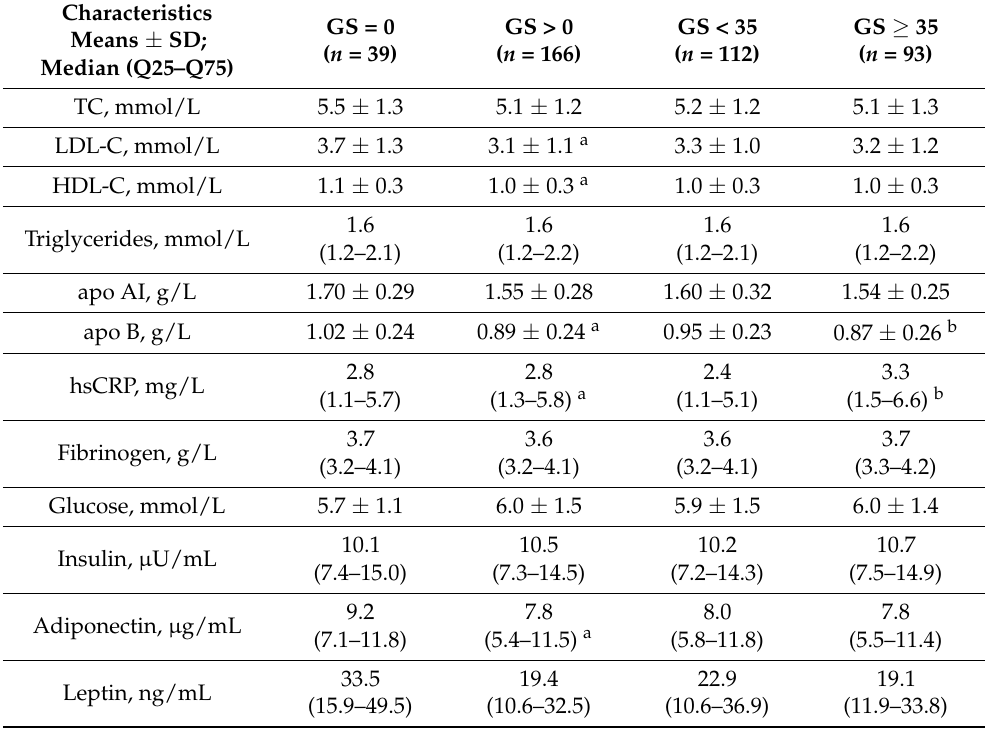
Table 1. Circulating biochemical parameters of the patients from the initial cohort.